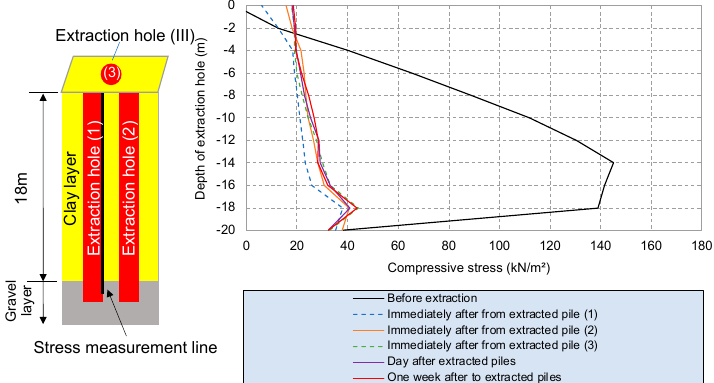
Figure 14. Compressive stress concentrated on three extraction holes of removed piles.